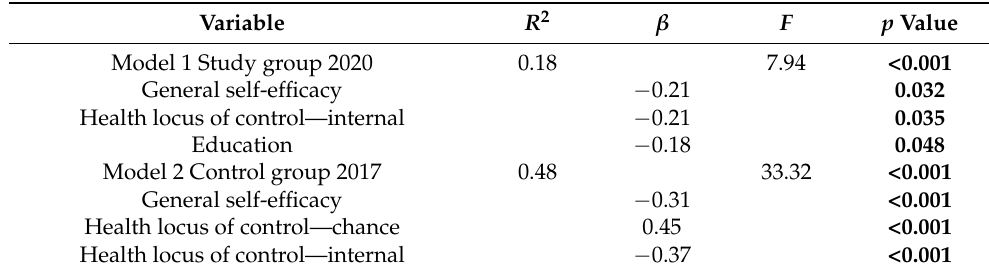
Table 4. Regression analysis predicting mental health in persons with MS studied in 2020 and control group studied in